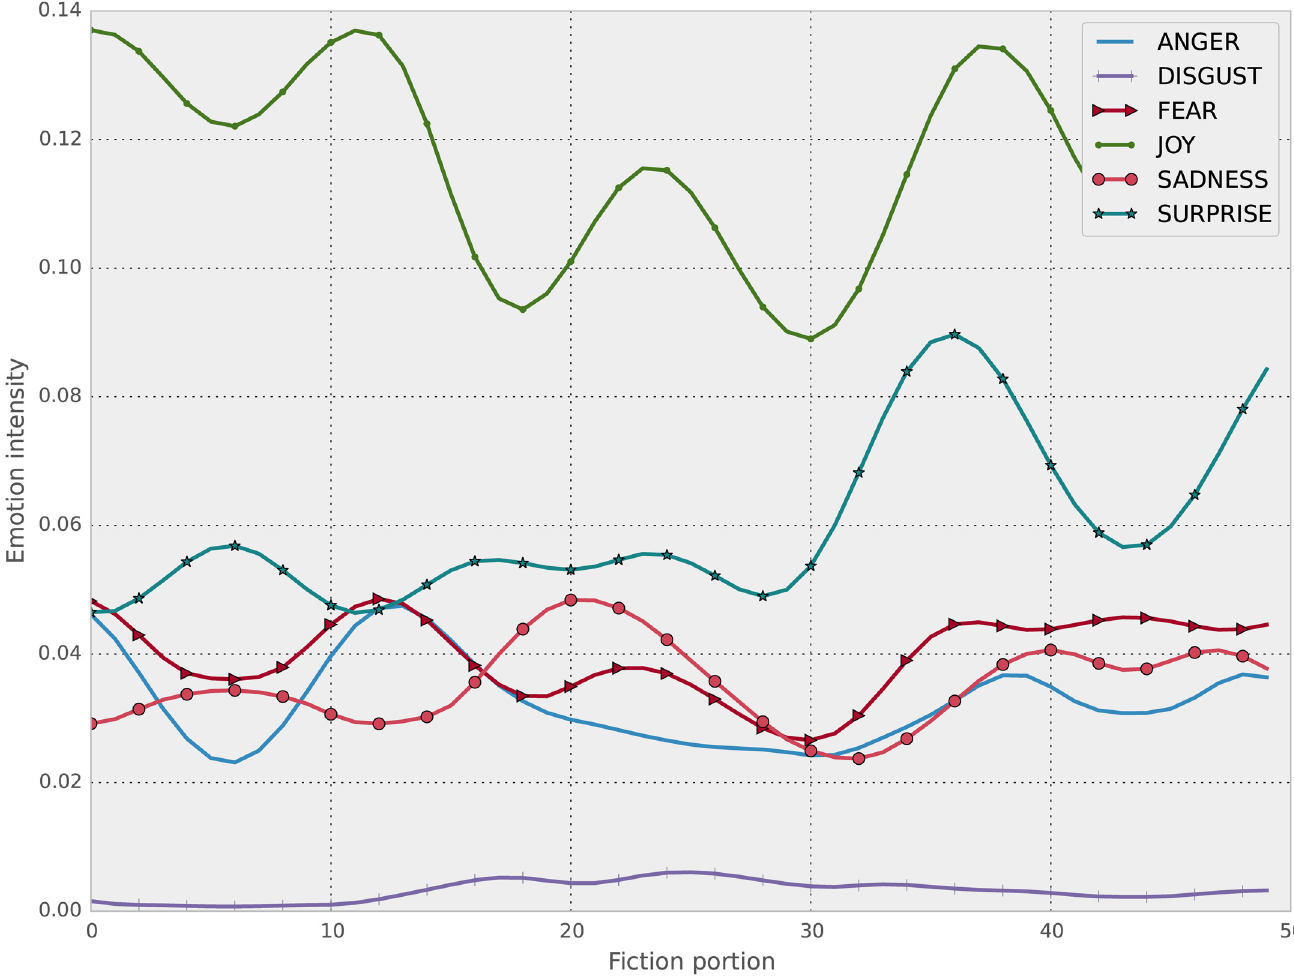
Fig 1. Emotional content for M URDER AT B RIDGE , by A NNE A USTIN , of class M YSTERY .